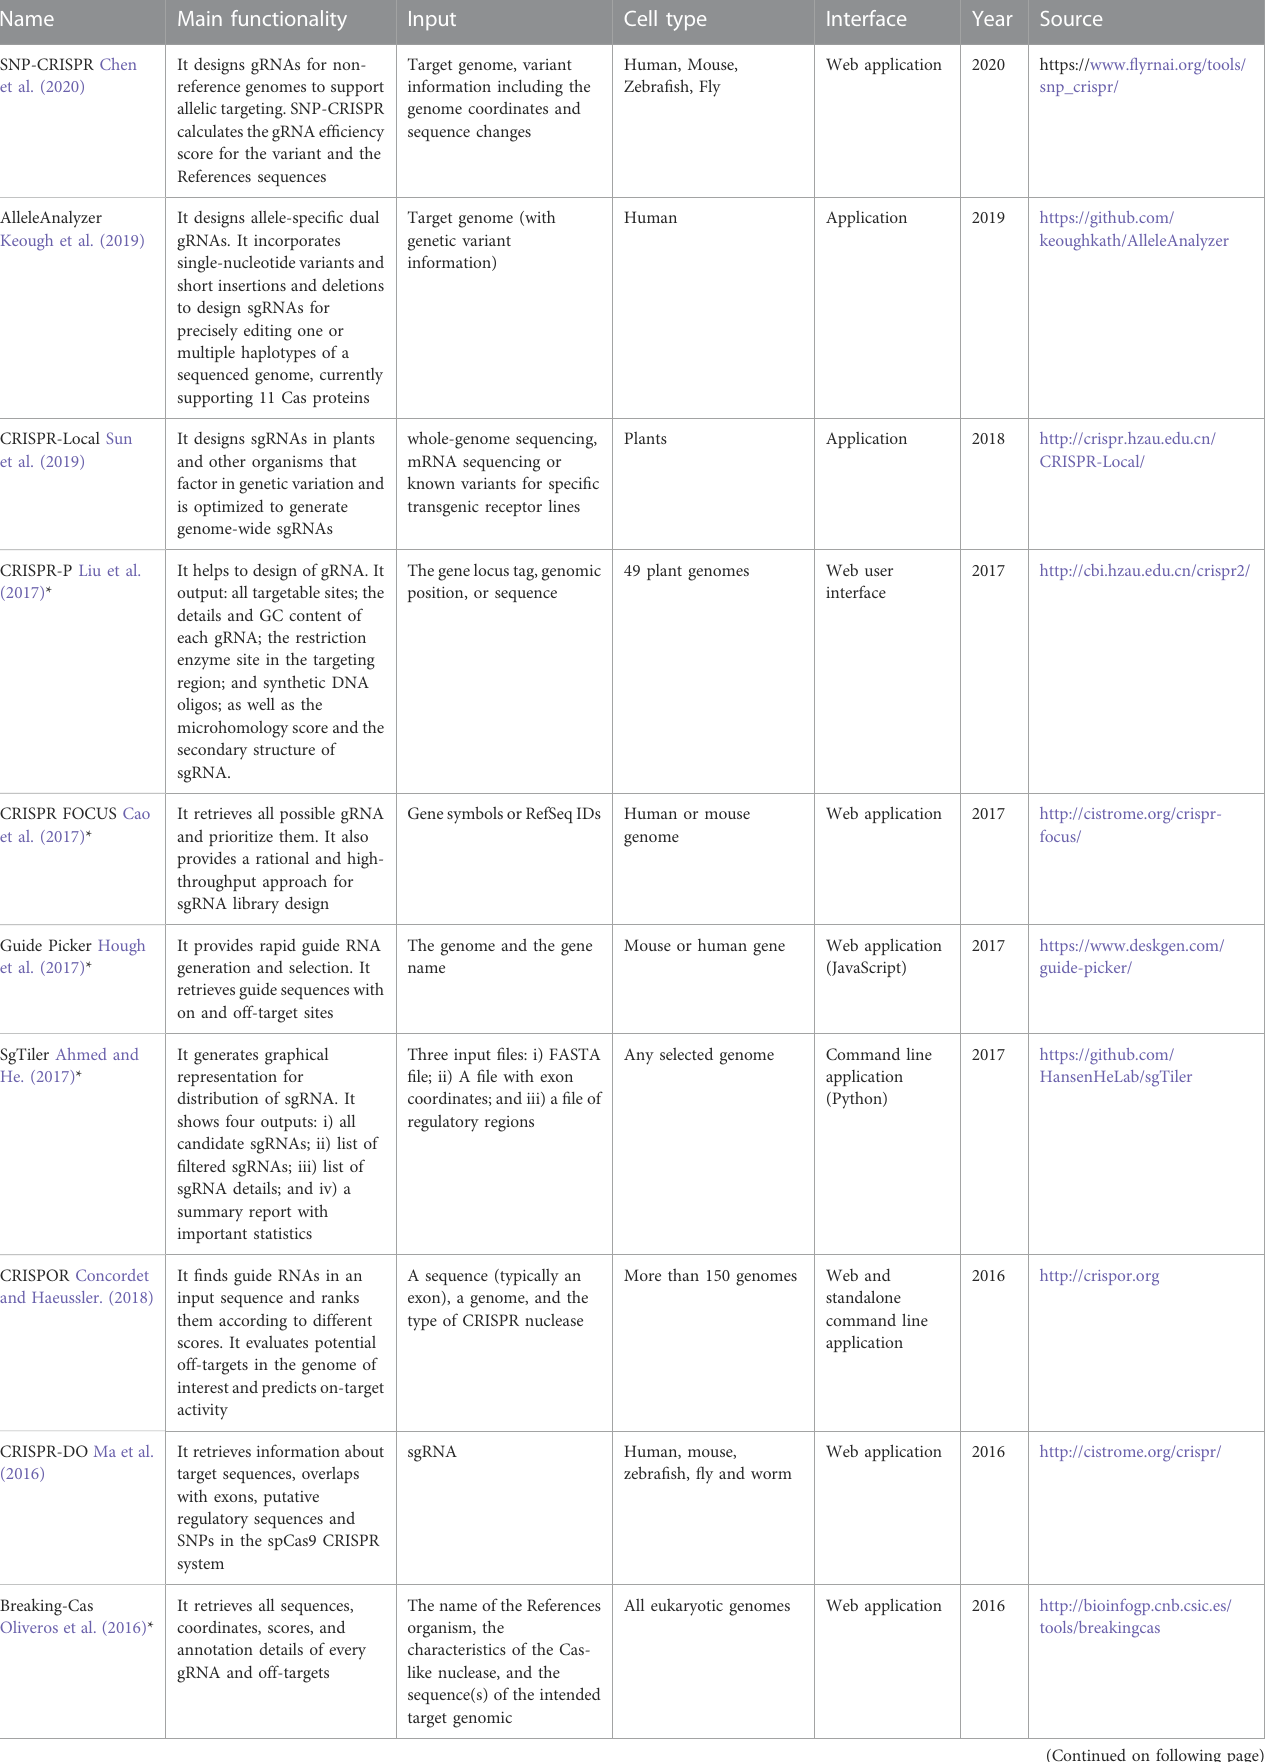
TABLE 3 Tools and software packages related to gRNA